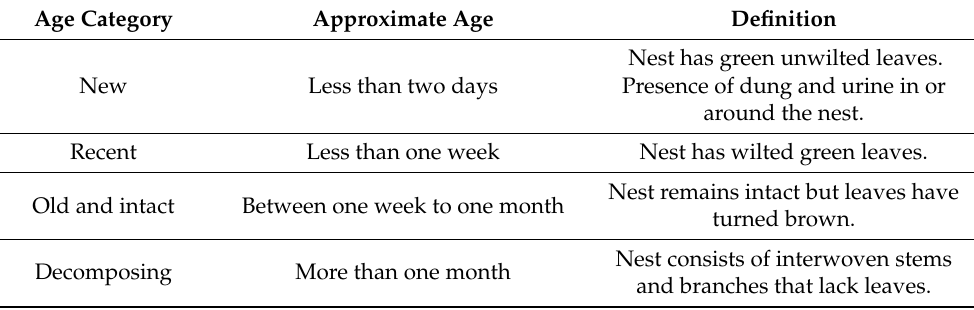
Nest has green unwilted leaves. Presence of dung and urine in or around the nest.